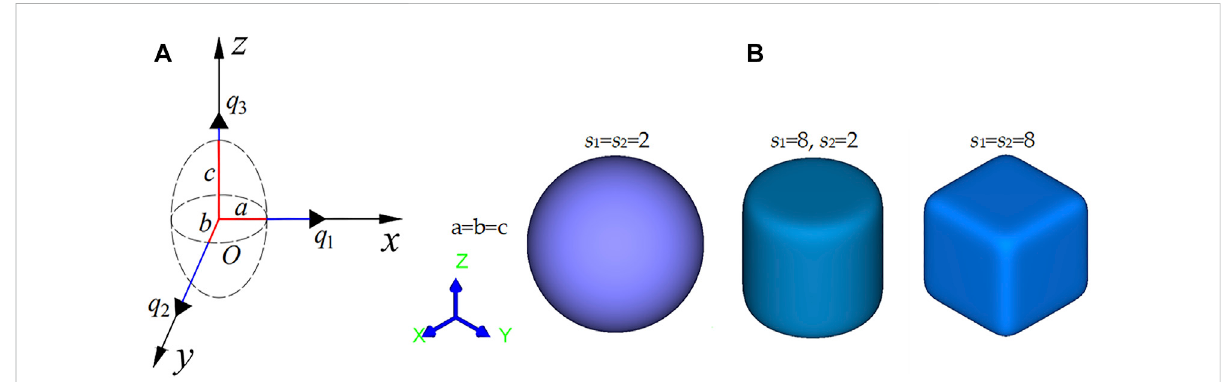
FIGURE 1 Superquadric elements in three dimensions: (A) standard model; (B) sphere, cylinder, and